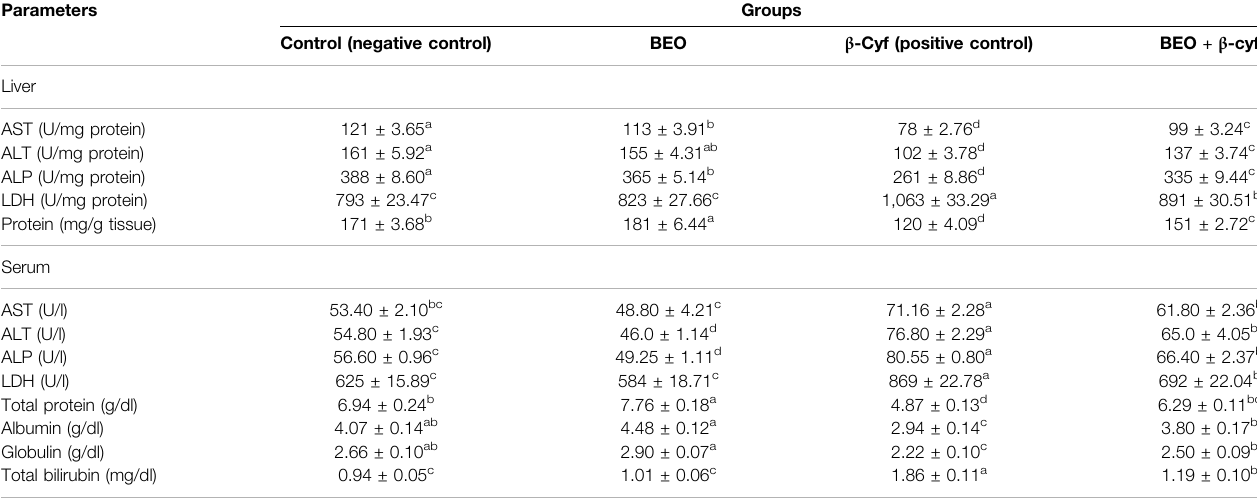
TABLE 6 | Liver function biomarkers in rats in different groups. Parameters Groups